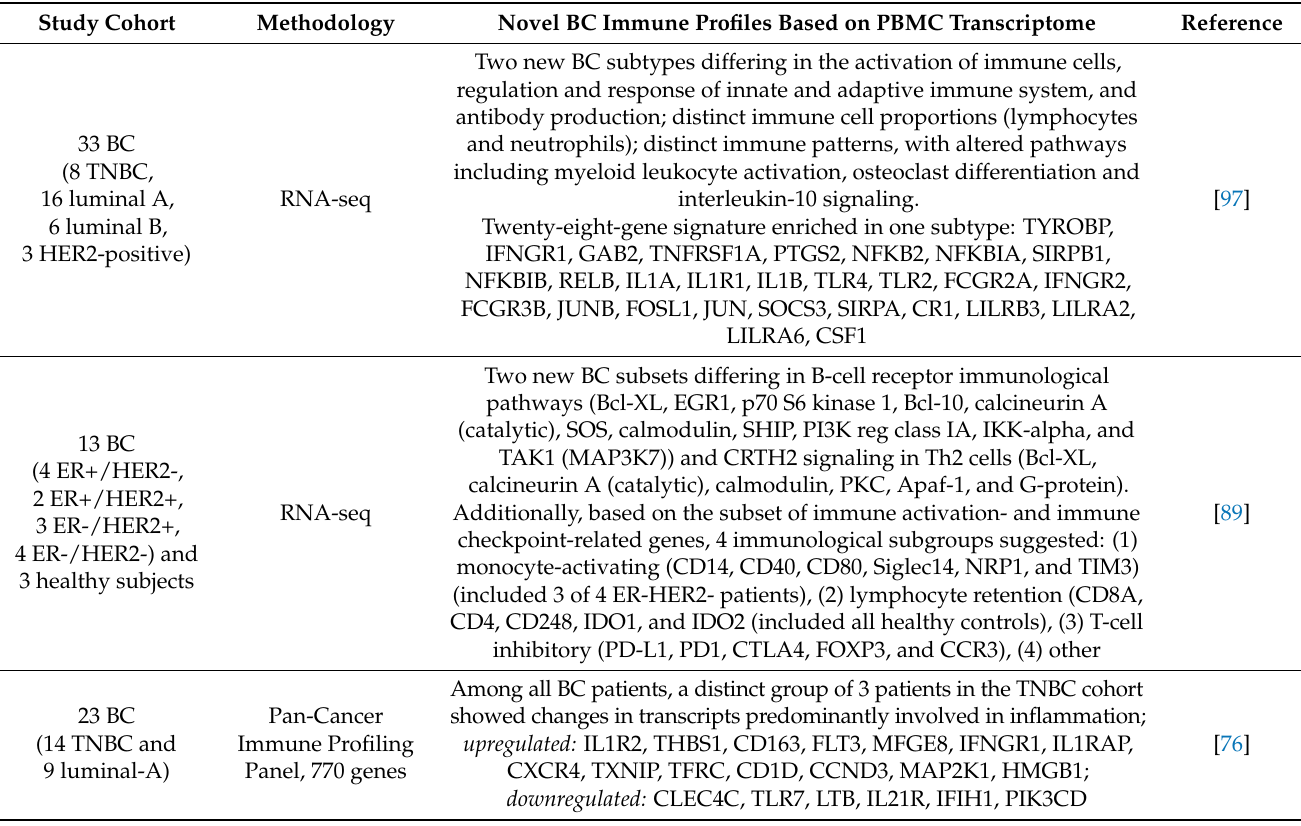
Table 1. Breast cancer immune subsets according to immunological properties of peripheral blood